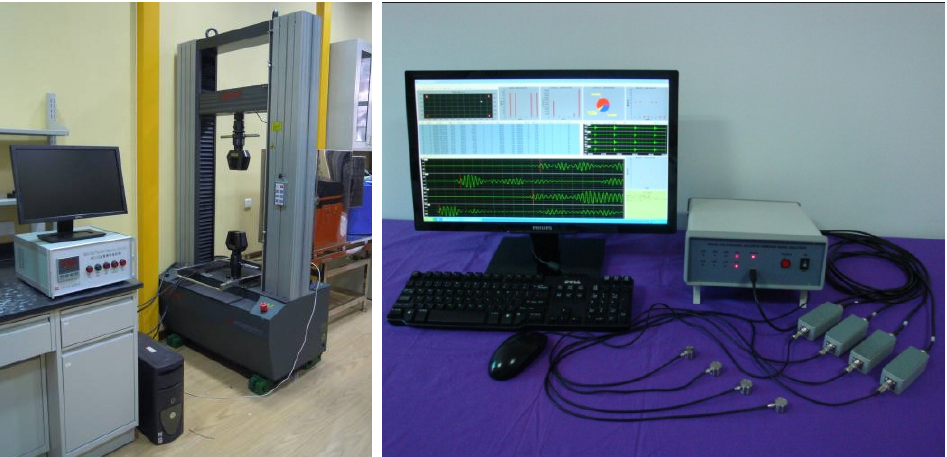
Figure 4. Electronic universal testing machine and AE instrument. Table 1. Freeze–thaw cycles and temperature setup.